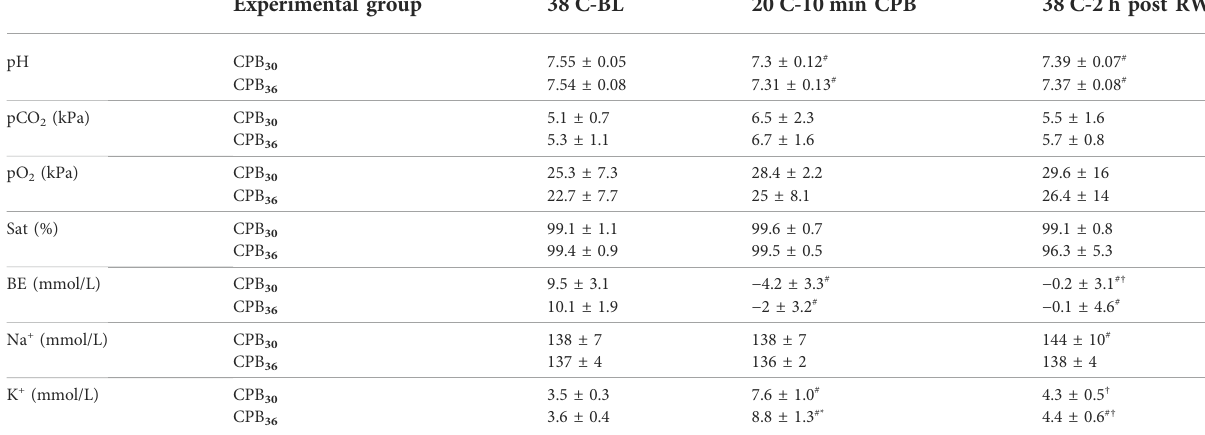
TABLE 3 Arterial blood gases